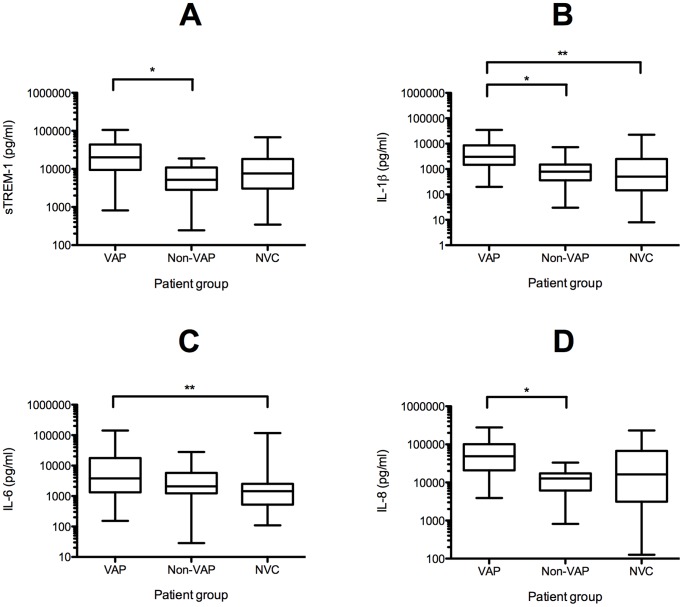
Soluble cytokine levels in BALF.Box (interquartile) and whisker (range) plots showing (a) sTREM-1, (b) IL-1β, (c) IL-6 and (d) IL-8 levels in BALF of patients with VAP, non-VAP (ventilated non-pulmonary infected control) and NVC (non-ventilated control). The BALF levels were corrected for dilution occurring with bronchoscopy using urea measurement. The concentration of BALF sTREM-1, IL-1β and IL-8 were significantly higher in VAP than non-VAP (p<0.001)*. BALF IL-1β and IL-6 were higher in the VAP compared with the NVC patient group (p<0.001)**.